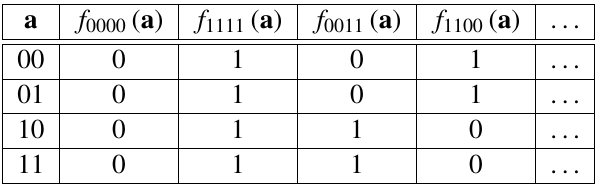
Table 2: Tabular representation of the functions f b ( a ) that are evaluated by the black box in the Deutsch–Jozsa